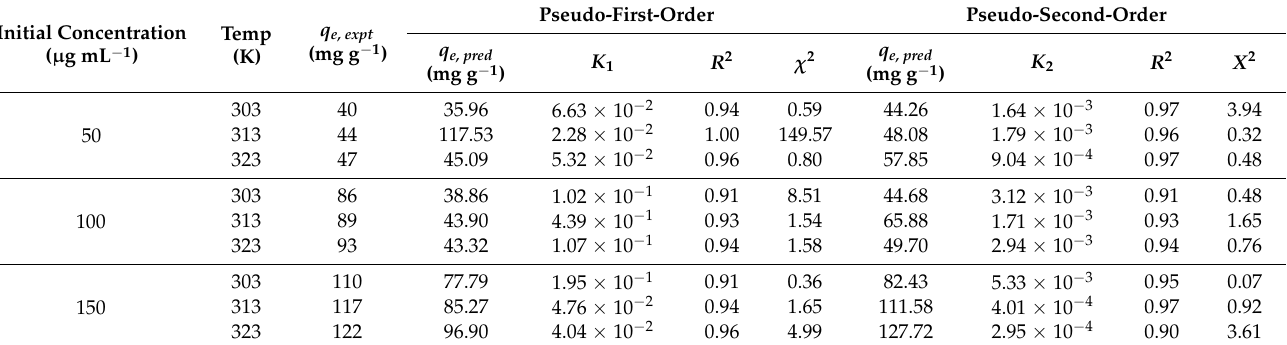
Table 4. Unsettled and hypothetically anticipated boundaries for the adsorption energy formats.